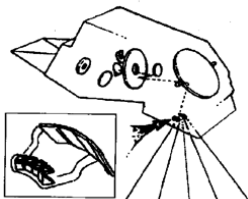
Figure 3. Solar calibrator of TM (Barsi J R, 2003a) Landsat-7 (1999.4.15) was the third-generation of Landsat series satellite, almost the same period with the launch of SPOT-4 (1998.3.24) satellite. ETM+ (Figure 4) first made the calibration algorithms public, improved the performance of the algorithm and software and was equipped with IAS system (Brian L.Markham, 2012a). There were two kinds of solar calibrators: full aperture solar calibrator (FASC) and partial aperture solar calibrator (PASC). FASC was made of PTFE. Its gray value quantization level was 9bit (8bit transmiited).